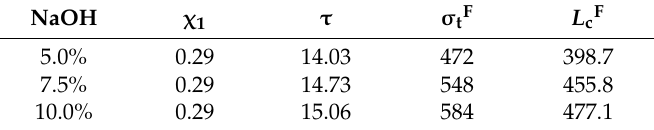
Table 5. Micro-mechanic properties of the reinforcing fibers and the interphase.